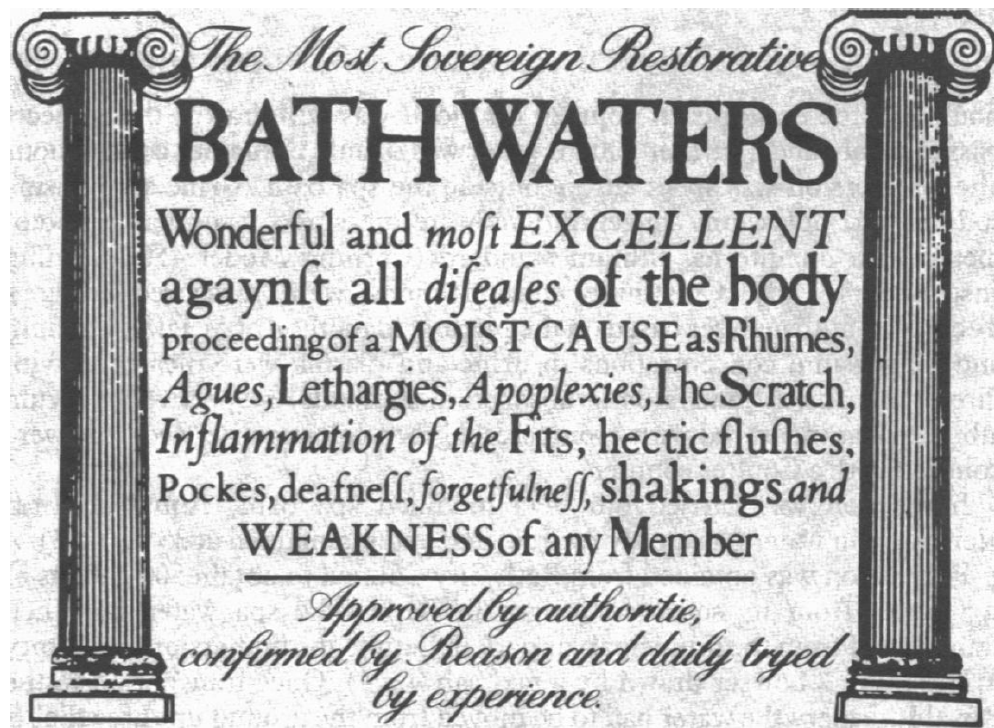
Figure 1. Eighteenth century bath card [16].